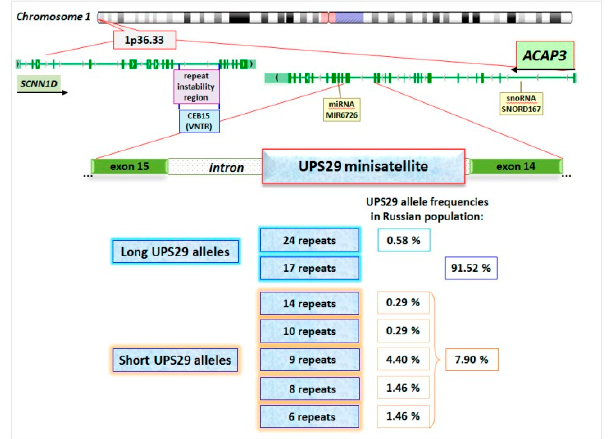
Figure 1. Scheme of chromosomal localization of ACAP3 and sodium channel epithelial 1 delta subunit gene ( SCNN1D ) genes, and intragenic location of UPS29 and CEB15 minisatellites. Allelic frequencies of long and short alleles UPS29 in the Russian population